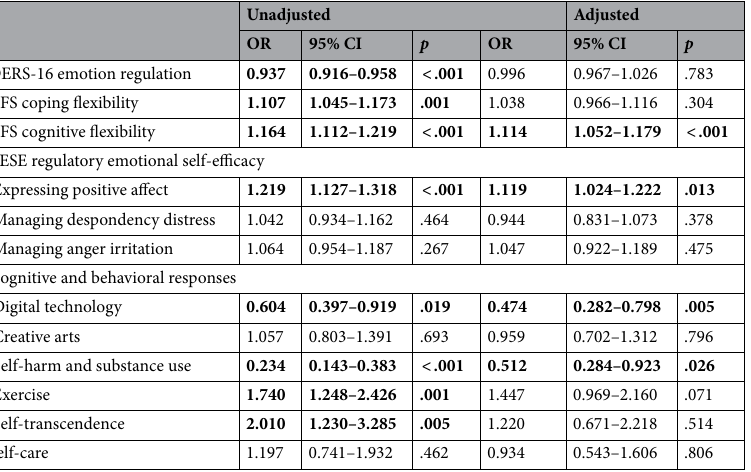
Table 4. Logistic regression models of cognitive emotion regulation factors in predicting the PD latent class (n = 557). Bold values indicate p < .05; PD: Positive Deviant; DERS-16: The Difficulties in Emotion Regulation Scale-16; CFS: Coping Flexibility Scale; CFS: Cognitive Flexibility Scale; RESE: Regulatory Emotional Self- efficacy Scale; the results were adjusted for age, sex, education, social economic status, severity of suicidal thoughts, depression, and anxiety, and positive and negative